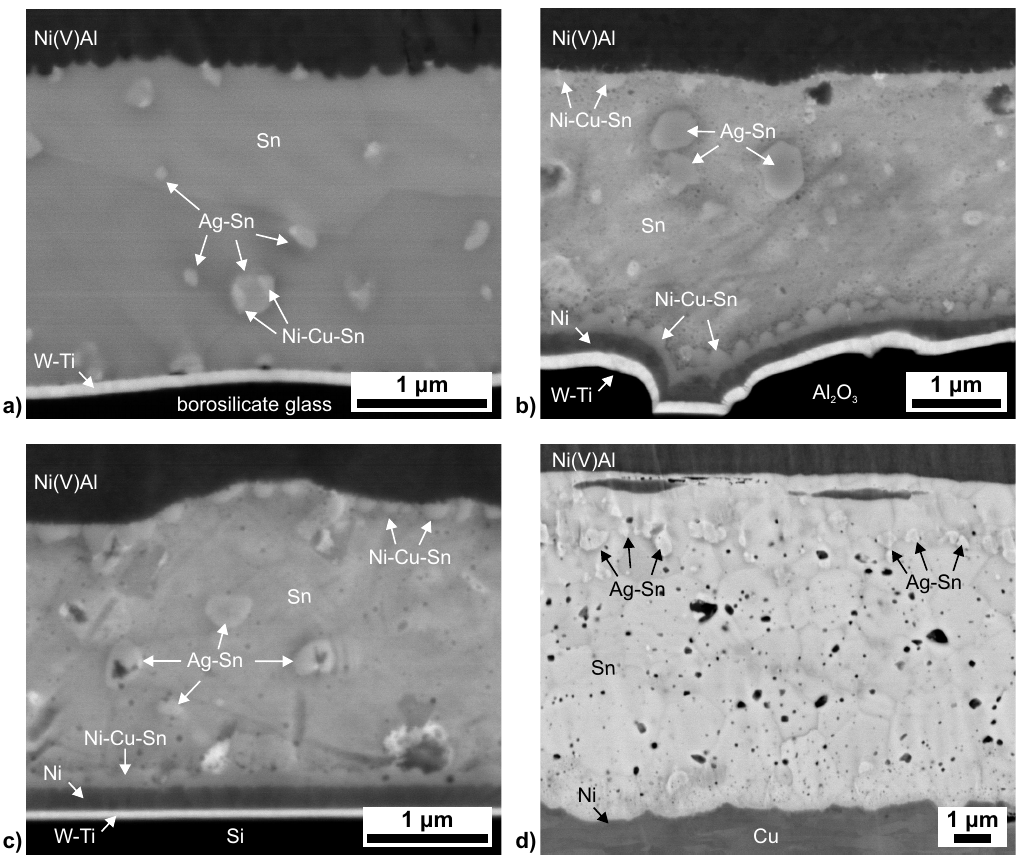
Figure 4. SEM micrographs (backscatter electron image) of the solder layer between substrate and RF layer for ( a ) borosilicate glass; ( b ) Al 2 O 3 ; ( c ) Si; and ( d ) Cu (compare Figure 1a). In case of Cu, the Ni-metallisation layer is virtually invisible due to the similar contrast of Cu and Ni. The micrographs show pronouncedly different microstructures, i.e., different types of intermetallics as well as a different spatial distribution of the intermetallics and of the porosity in the solder